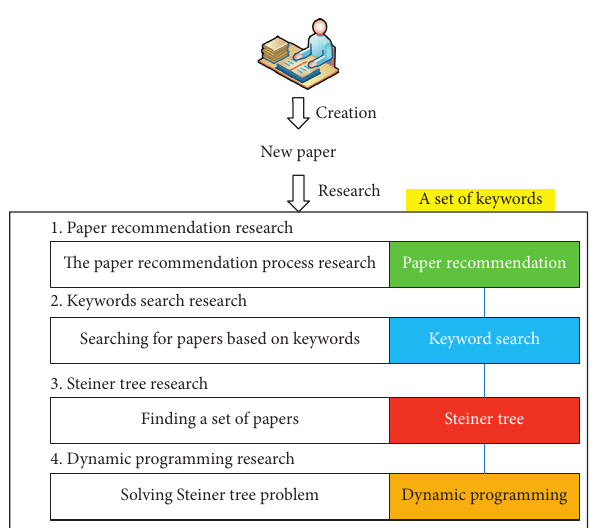
Figure 2: An example of paper’s research and creation task.